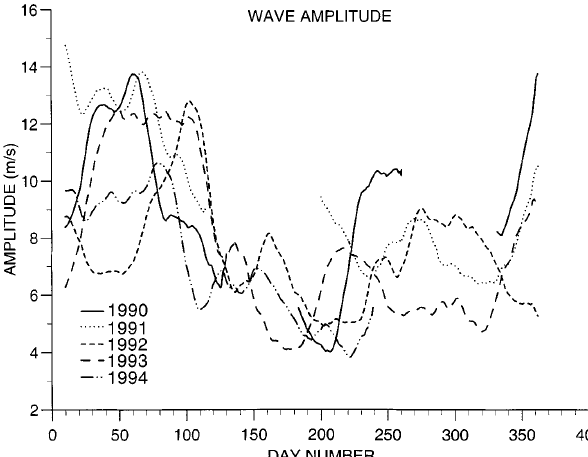
Fig. 3. Amplitudes of the largest spectral signature in either zonal or meridional winds in the frequency range 0.1–0.035 cycles/day (10–28 days period) as a function of time for the